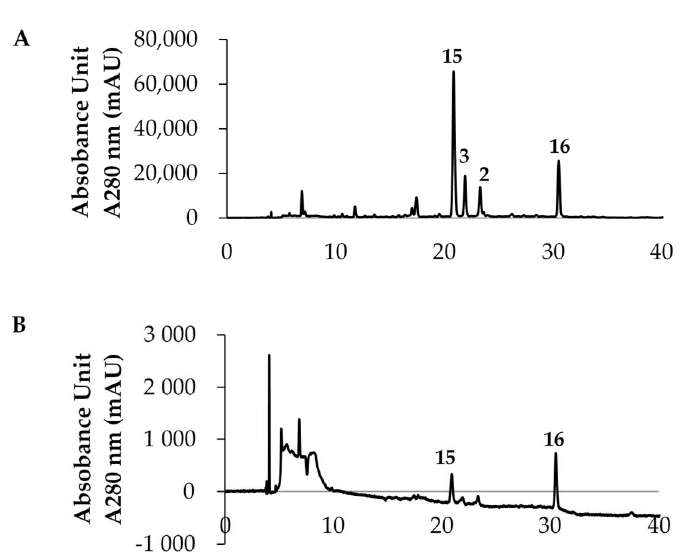
Figure 5. HPLC chromatograms of the supernatant and eluate of gelatin. HPLC chromatogram ( A ) of the supernatant after adding 1 µ L of 100 mg/mL green tea leaf extract (equivalent to 100 µ g of dried tea leaves) to 100 µ L of gelatin suspension (equivalent to 250 µ g of dried gelatin) and incubating. HPLC chromatogram of the solution eluted with methanol ( B